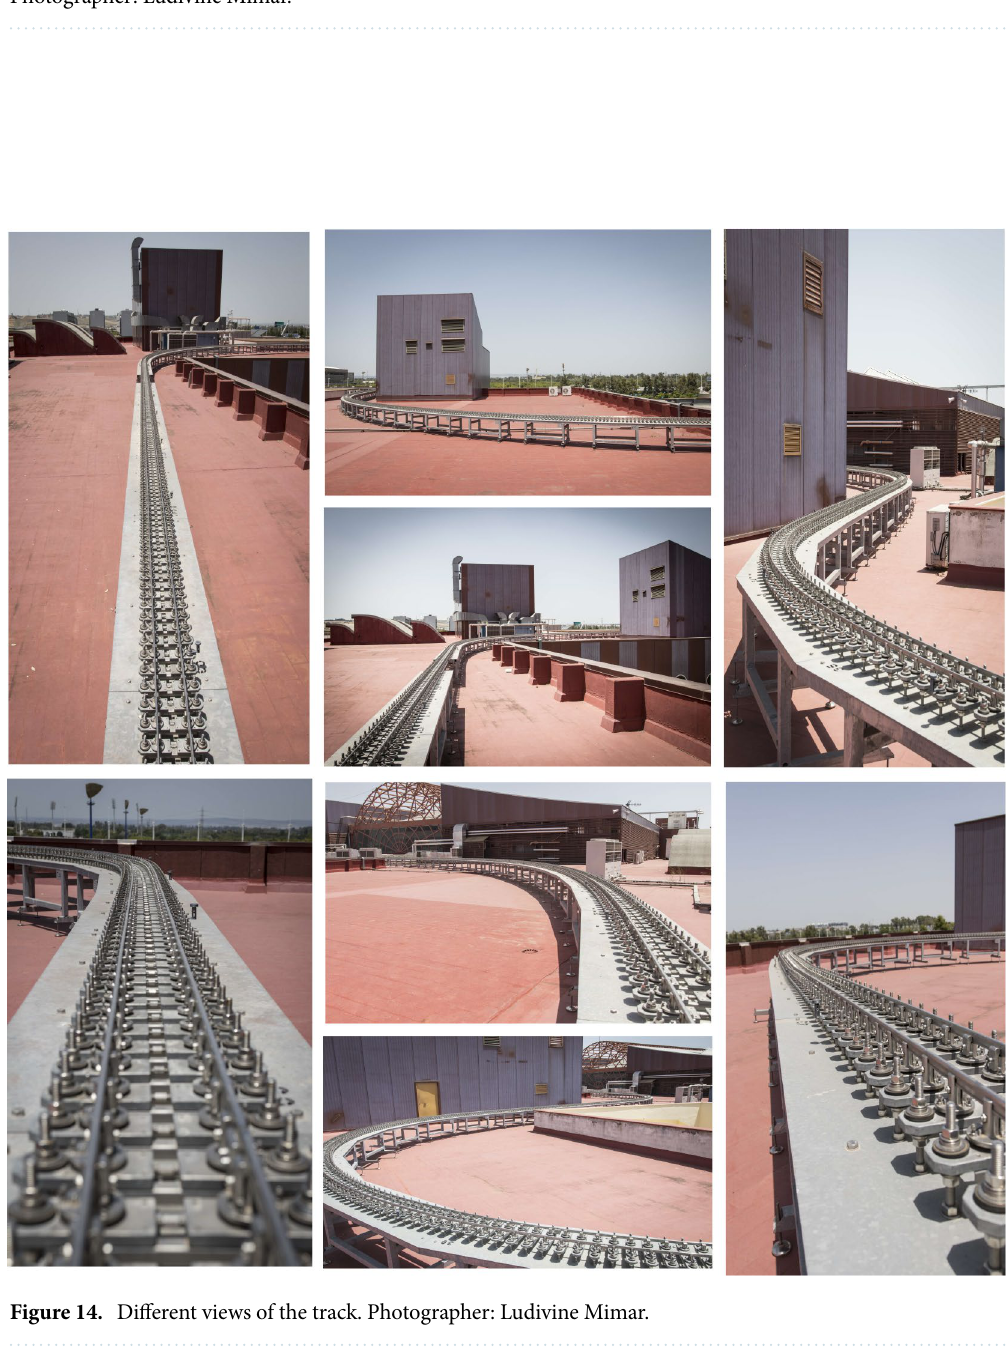
Figure 14. Different views of the track. Photographer: Ludivine